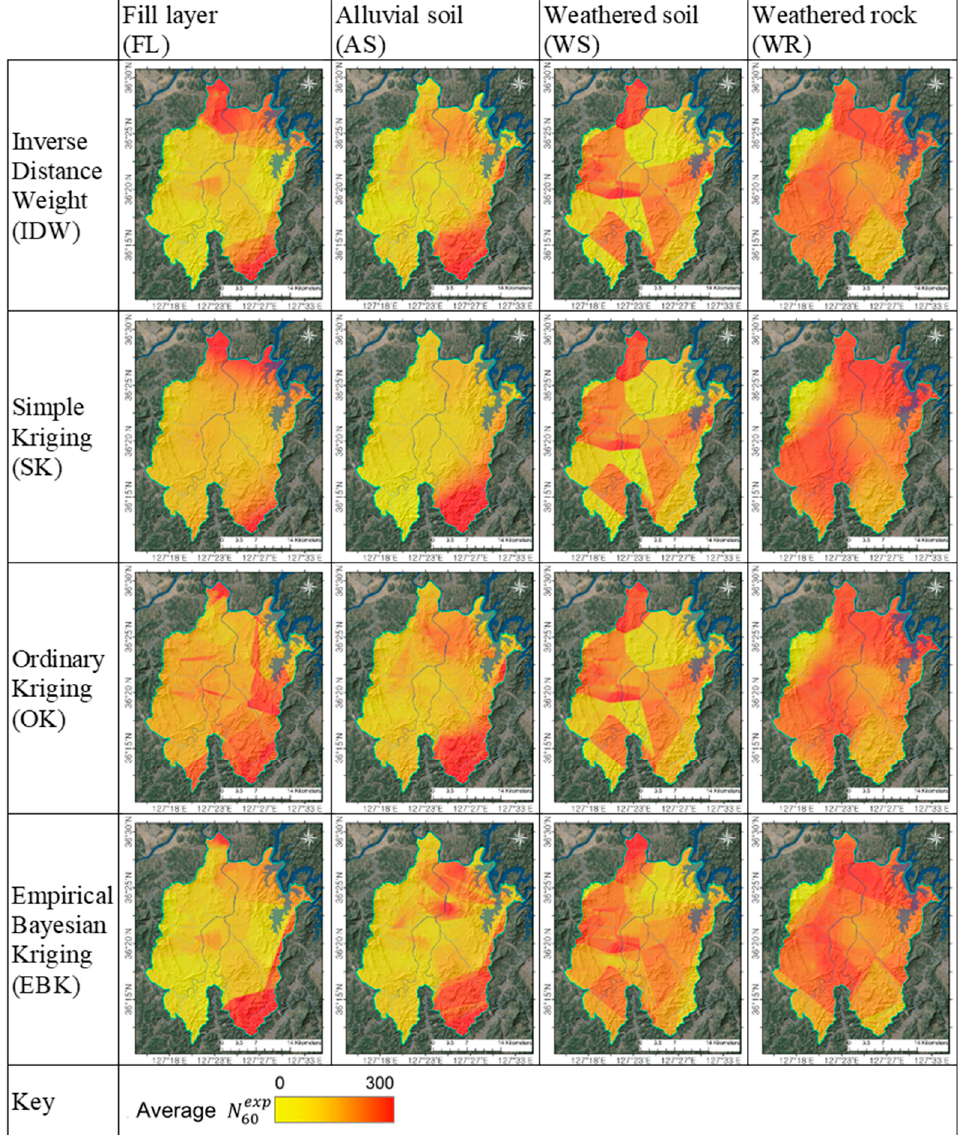
Figure 7. Comparison of geospatial maps of average 𝑁 (cid:2874)(cid:2868)(cid:3032)(cid:3051)(cid:3043) between different geostatistical interpolation algorithms including: Inverse Distance Weighting; Simple Kriging; Ordinary Kriging; Empirical Bayesian Kriging.